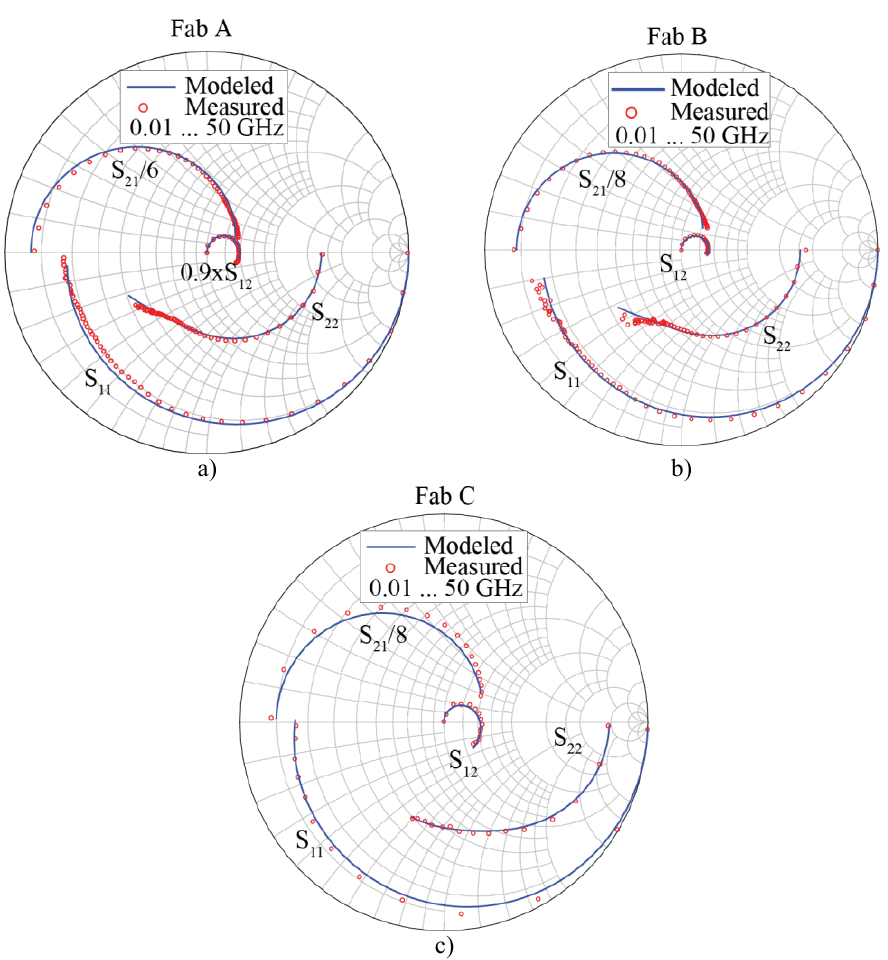
Fig. 2. A comparison between simulated and measured S-parameters of pHEMTs, manufactured at fab A (a), fab B (b) and fab C